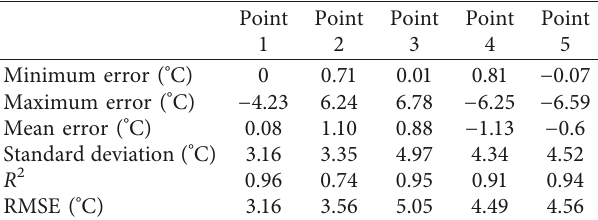
Table 6: Model fit between simulated and measured results for mean radiant